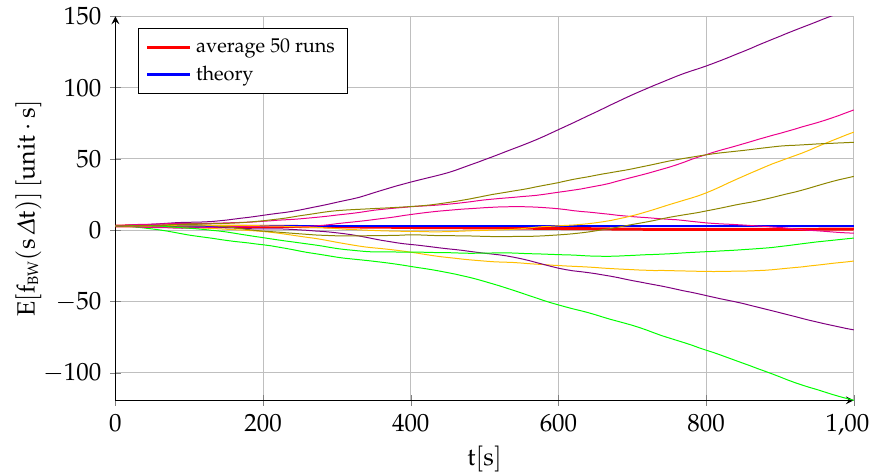
Figure 4. Propagation with time of first integral of sensor error mean.